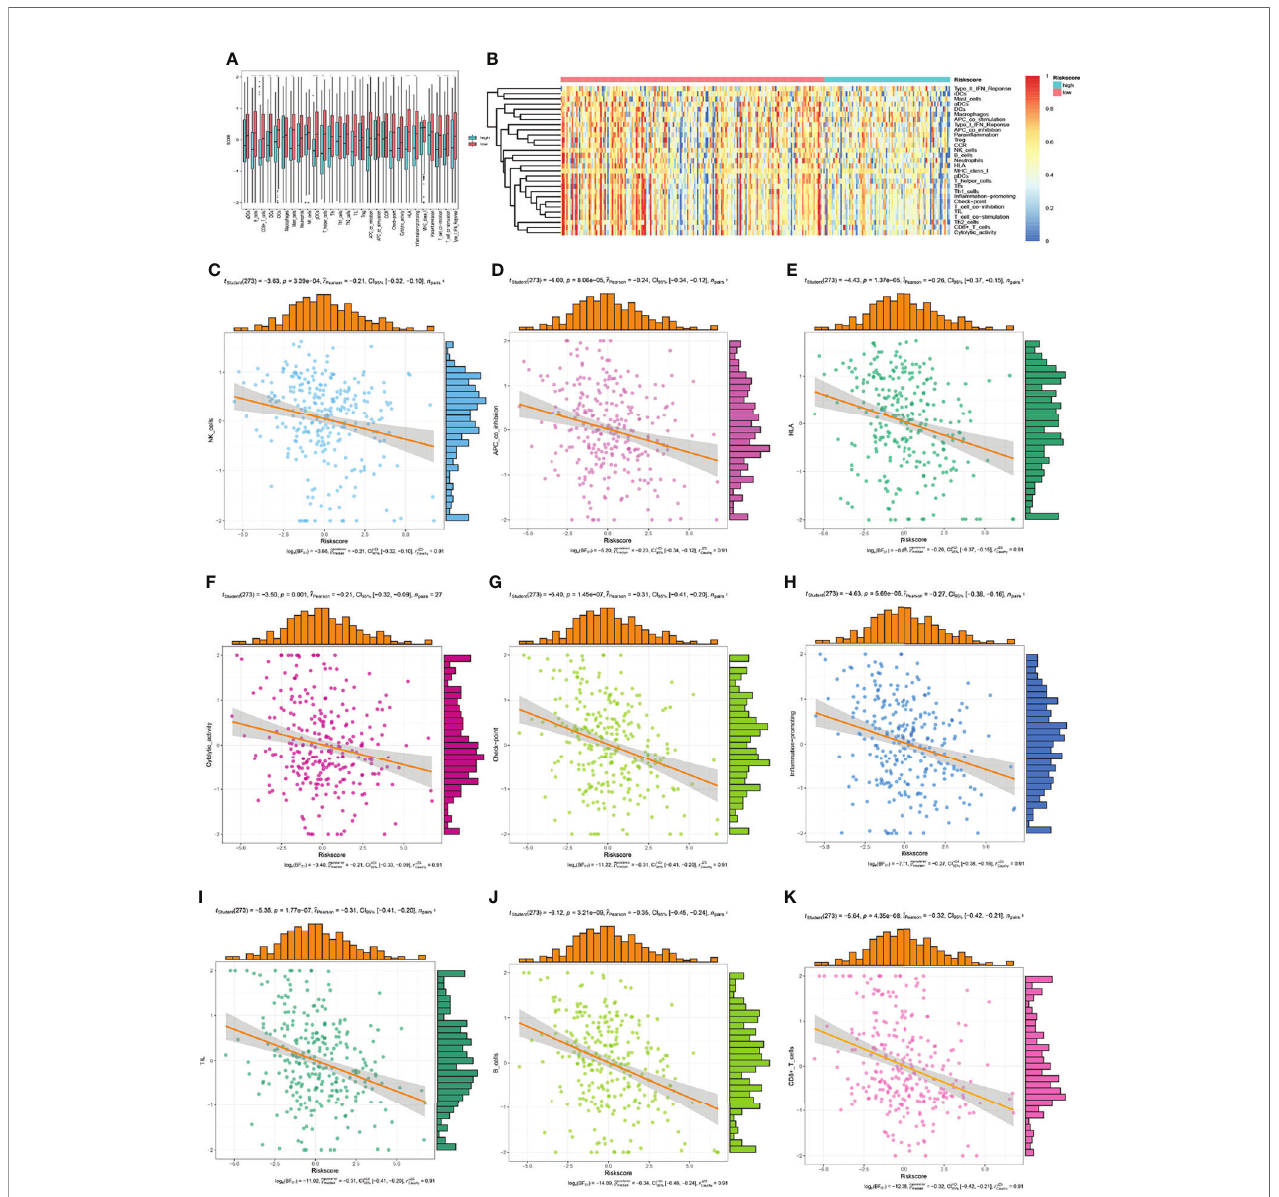
( Figure 12B ). The p -value of the signature prediction for the OS of melanoma treated with CTLA4 is less than 0.05. Above results suggesting that this signature and related genes may be robust predictive biomarkers for immune checkpoint blockade